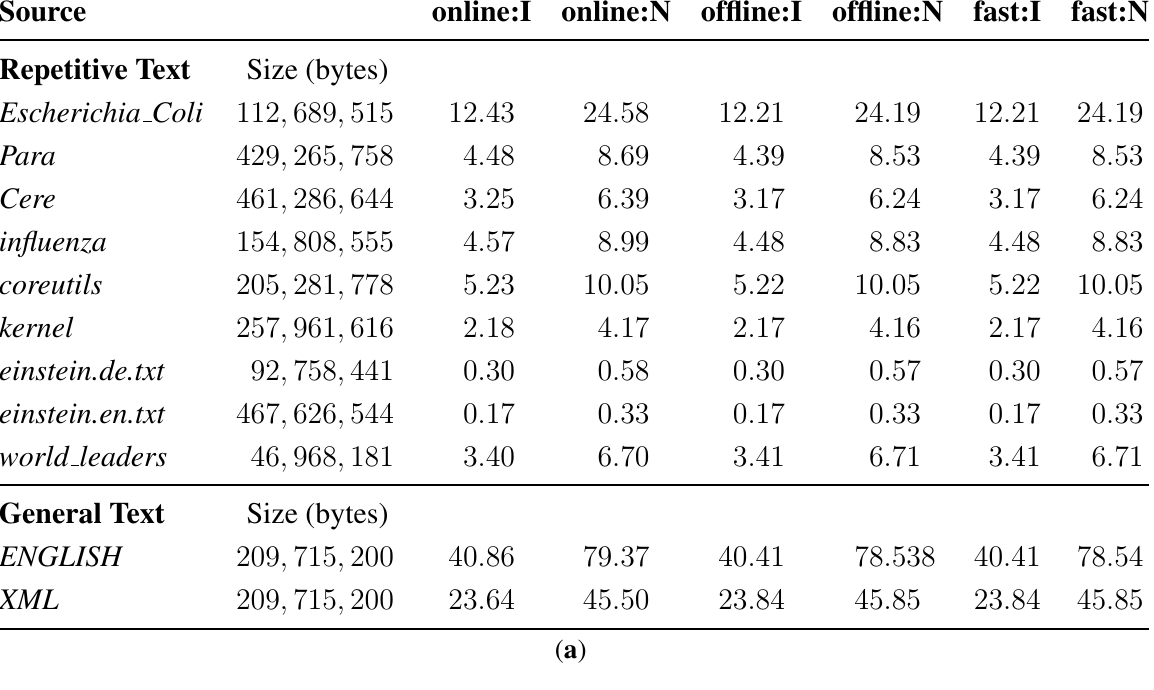
Table 3. Experimental results for LCA variations. ( a ) Compression ratio (percentage of the compressed size over the text size); ( b ) Main memory consumption (fraction of the text size); ( c ) Compression time (seconds per